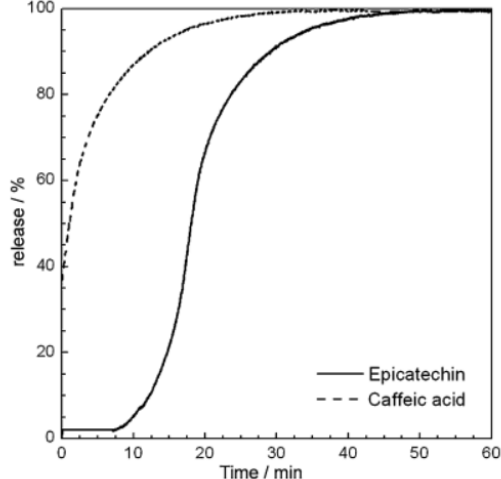
Figure 6. Epicatechin and caffeic acid release profiles of dry microcapsules obtained by spraying in an aqueous solution Reprinted from [130] with permission of publisher.